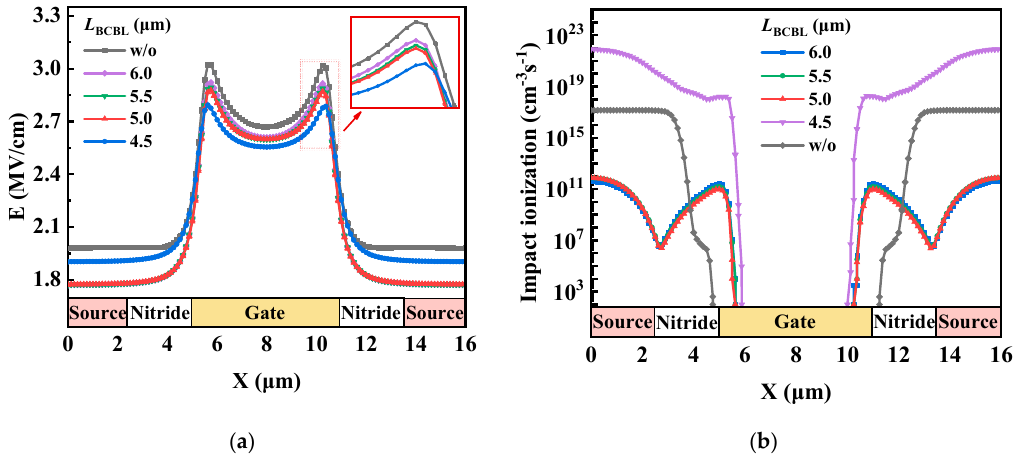
Figure 7. Distributions of ( a ) electric field and ( b ) impact ionization concentration near the gate in the BCBL-VFET with the changed L BCBL .